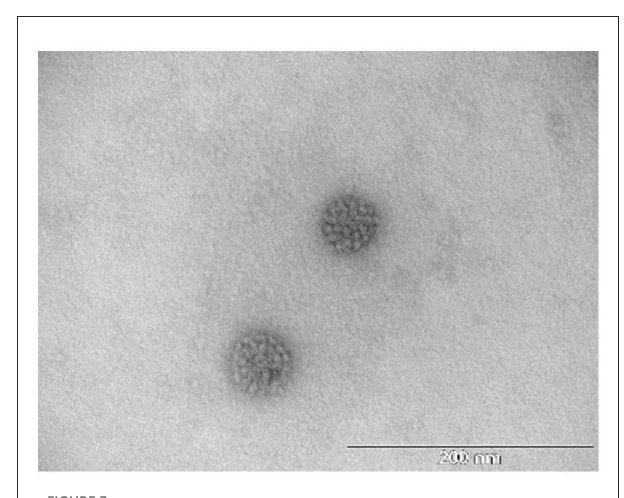
FIGURE3 TEM micrographs of the isolated BPV1 L1 VLPs. Scale bar =